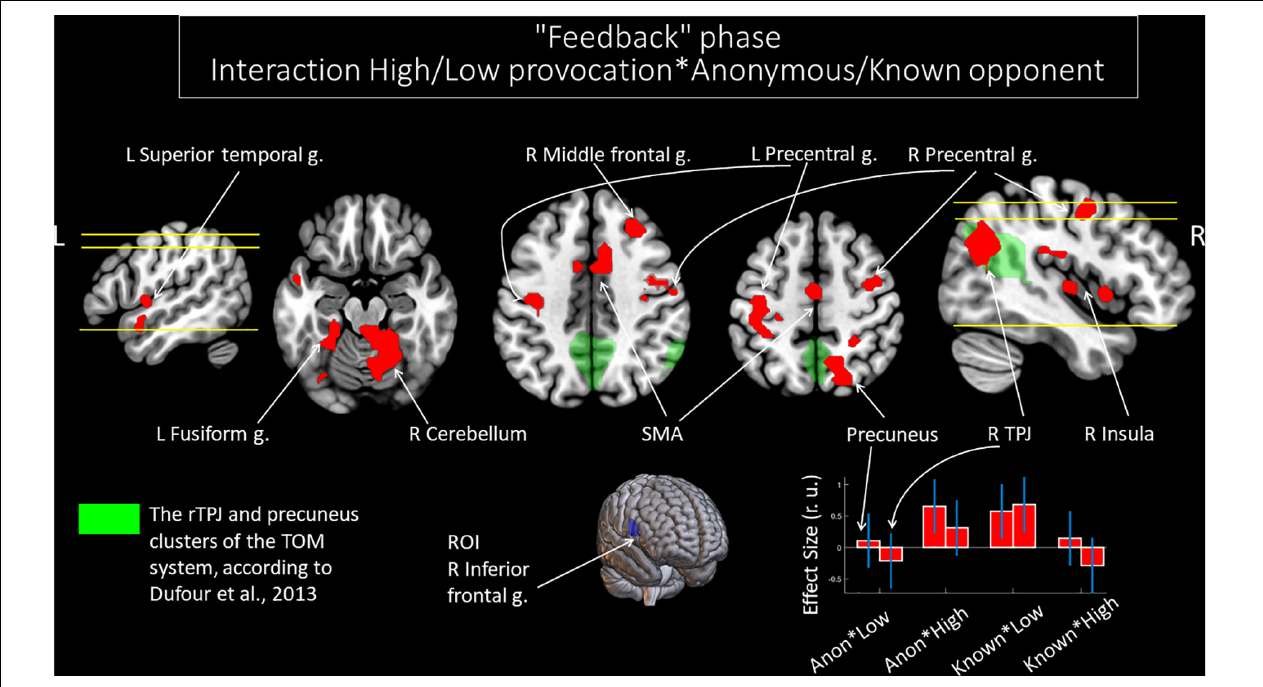
FIGURE 5 | Results of the group-level gPPI analysis with the ROI in the right IFG. Clusters of significant changes in functional connectivity with the right IFG, associated with the interactions between the level of observed provocation and the anonymity of the opponent (uncorrected p < 0.001 at the voxel level, FWE-corrected at the cluster level p < 0.05, and k = 15), are shown in red. The TOM system clusters are presented in green according to the results of Dufour et al. (2013). The plot on the lower right side indicates effect sizes with 95% confidence intervals. L/R, left/right hemisphere; g., gyrus; TPJ, temporoparietal junction; SMA, supplementary motor area; ROI, region of interest; Anon, anonymous opponent; Known, introduced opponent; High, high provocation; Low, low